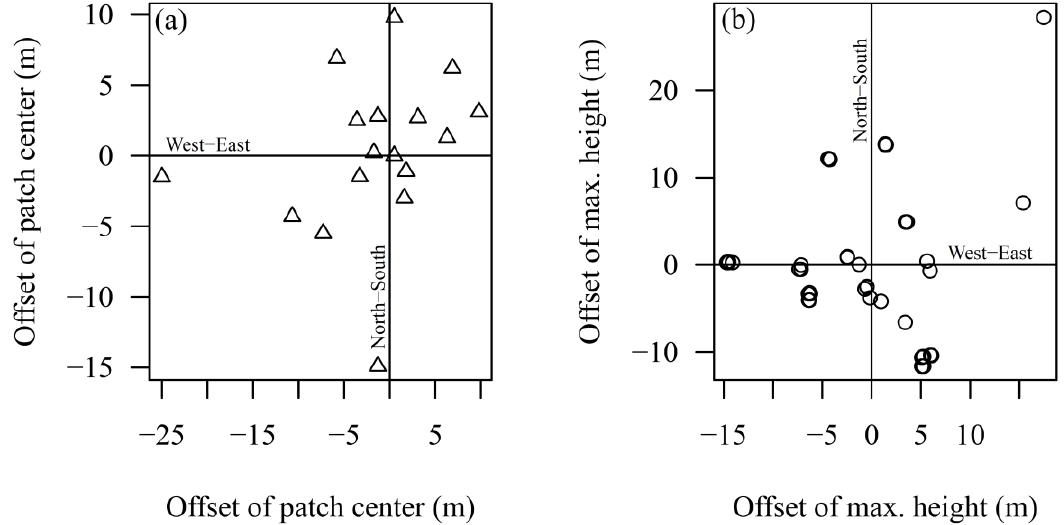
Figure 8. Horizontal shift ( a ) of the regeneration patch center relative to the center of the canopy opening (0 / 0), respectively and ( b ) horizontal shift of the maximum height within the regeneration patch relative to the center of the regeneration patch (0 / 0), respectively. Open triangles mark the position {x / y} of the regeneration patch center (a) and open circles mark the maximum height within the patch (b). The point (0 / 0) in the two-dimensional coordinate system is equivalent to the projected center of the canopy gap (a) or the center of the regeneration patch (b).